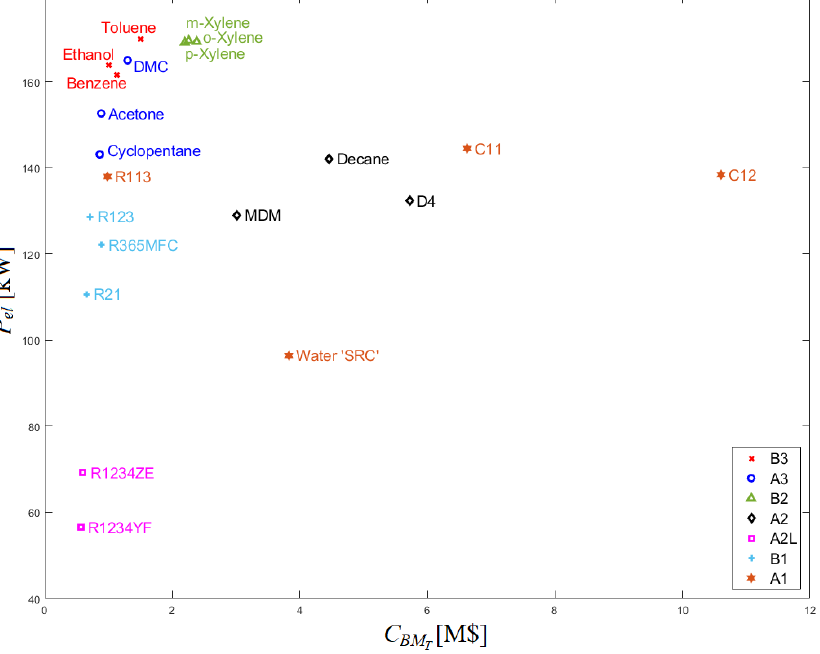
Figure 5. Net output power versus plant cost of the best 3 fluids of each safety category in the case of no thermal loop.